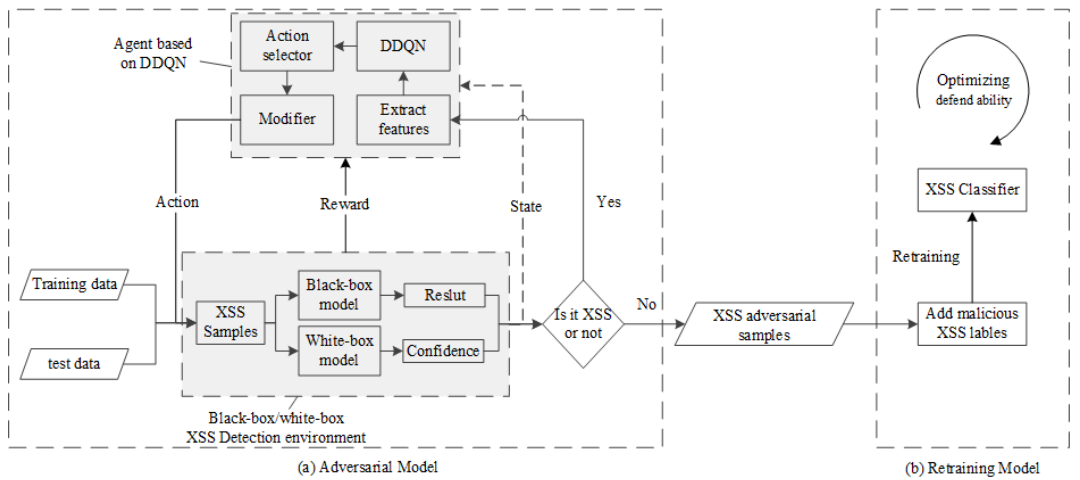
Figure 1. Architecture of reinforcement learning cross-site scripting